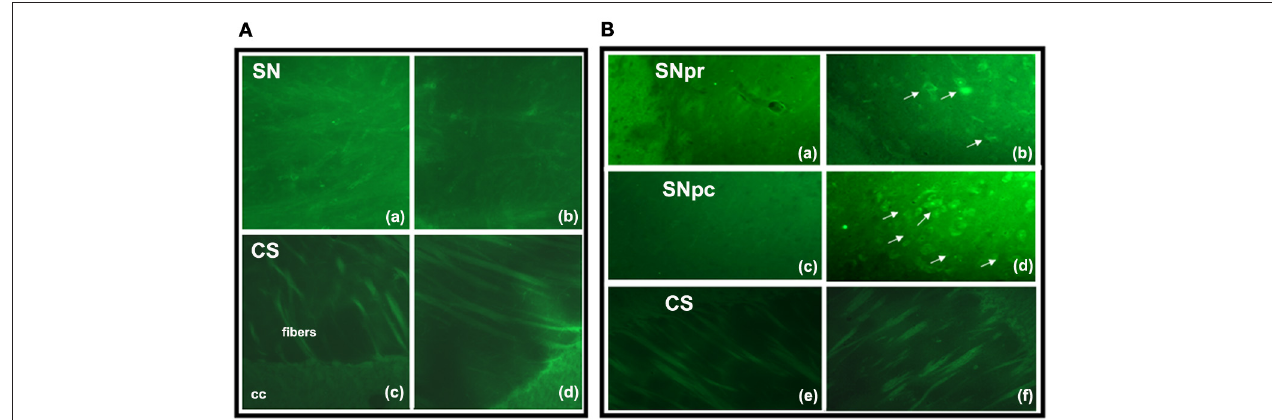
reticulata (Bb) and pars compacta (Bd) of EF2 group while no labeling in these regionswas seen in the controls (Ba, Bc) . No FJC labeling was detectedin cell bodies of the CS in the EF2 (Bf) or control (Be) groups. A slight and non-specific labeling was seen in regions rich in myelin such as cerebral